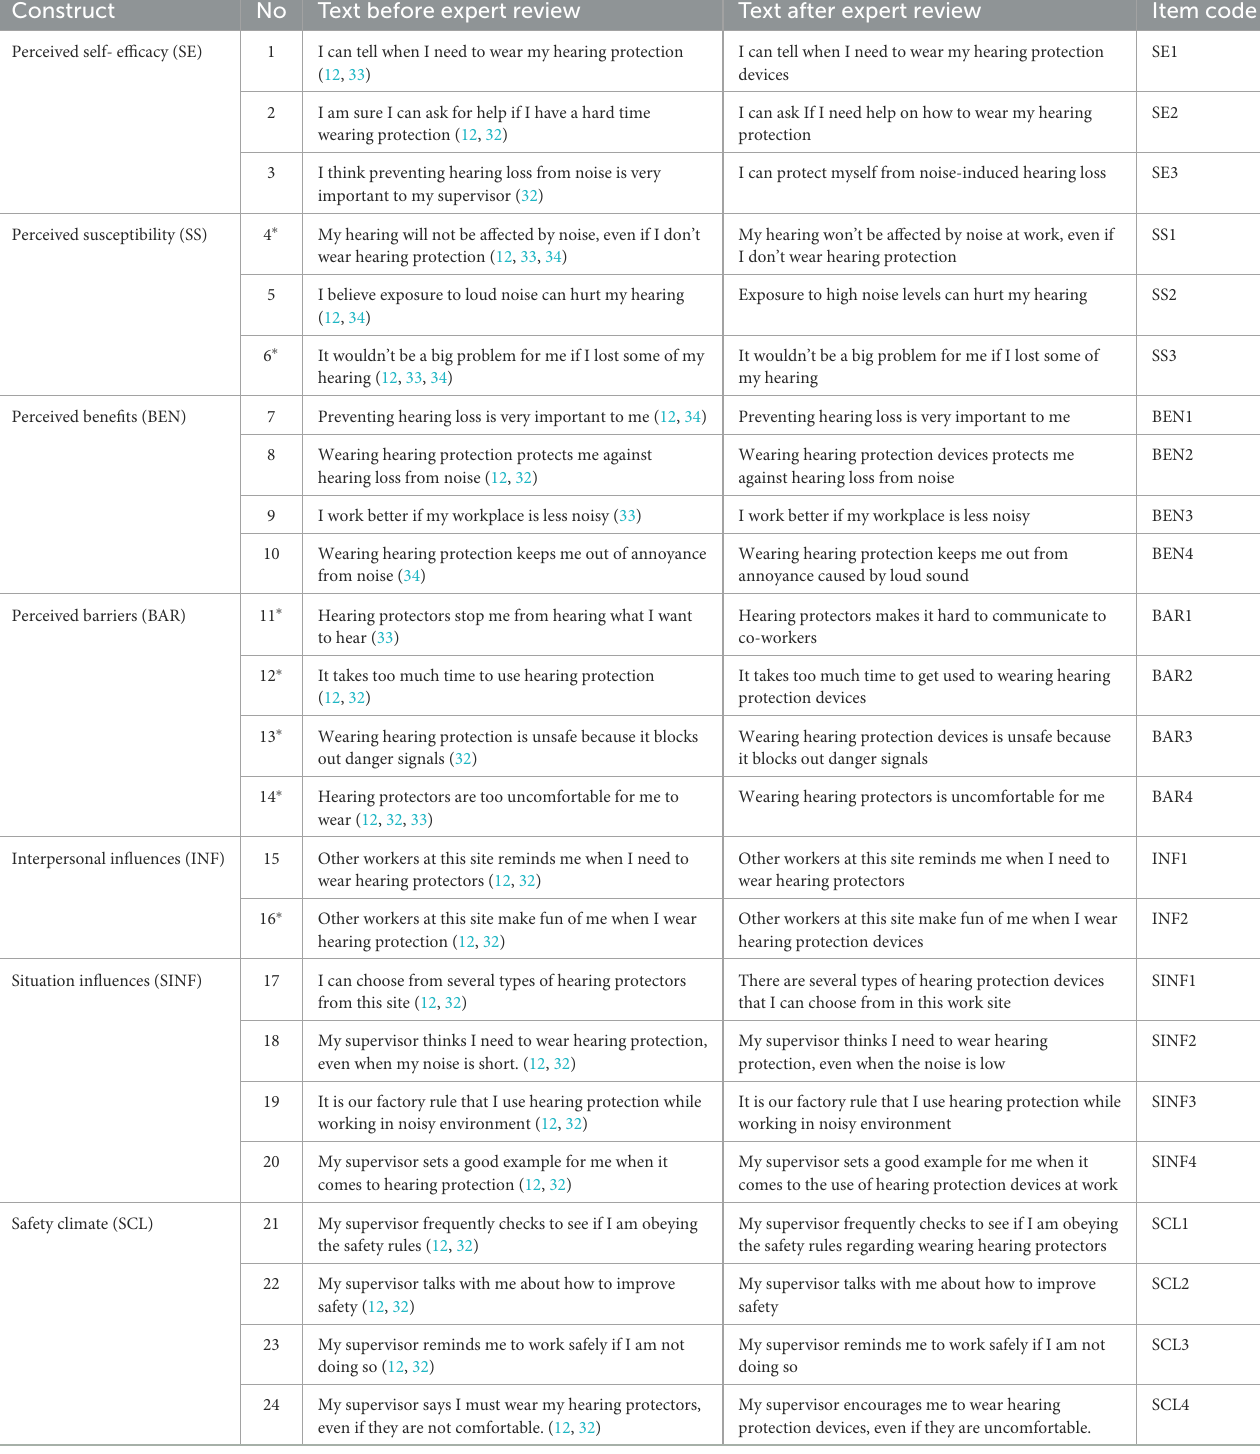
TABLE 1 Items in the developed questionnaire before and after expert review process.